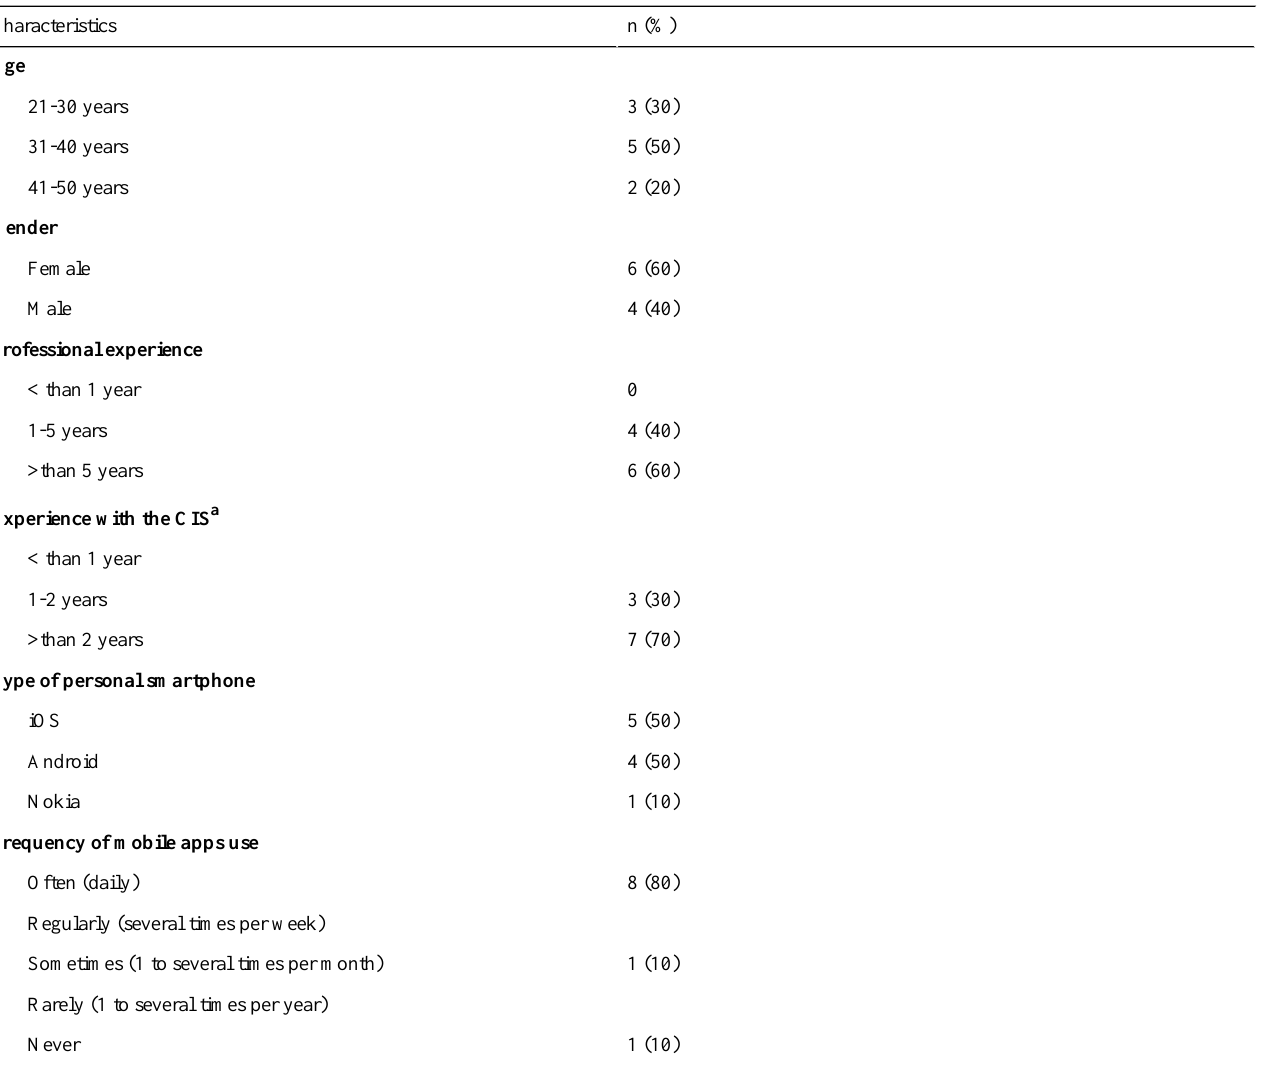
Table 1. Demographics of the study participants